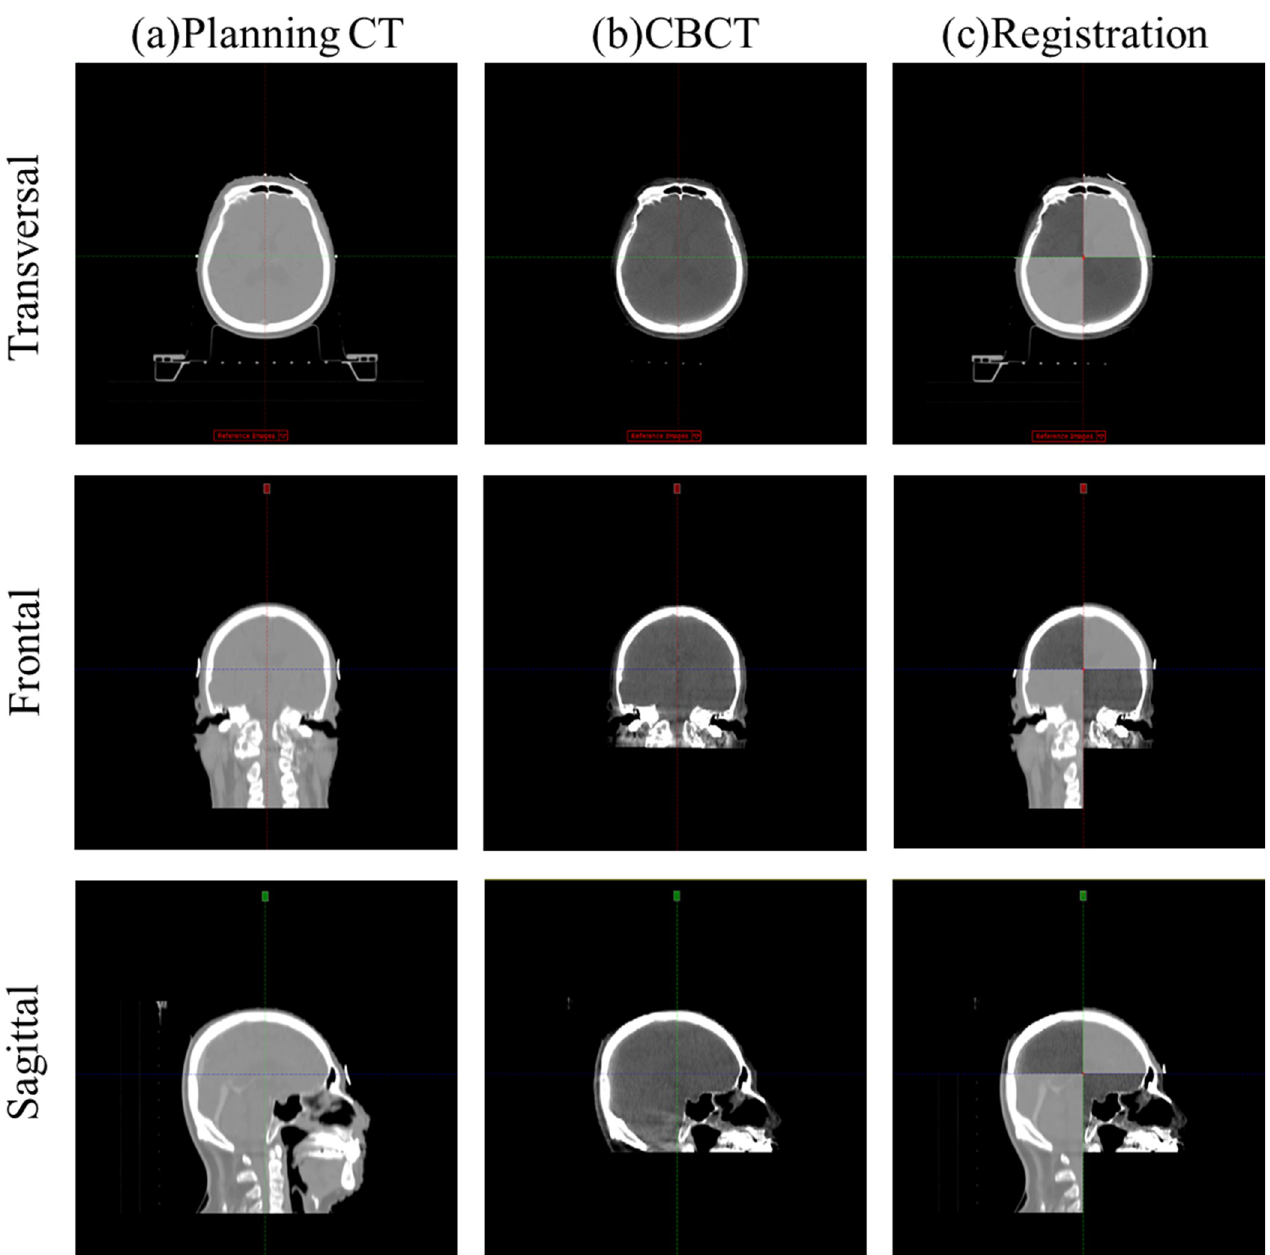
Fig 2. Image registration using the planning computed tomography (CT) and cone beam CT (CBCT) in the c-SP. (A) Planning CT, (B) CBCT, and (C) registration image.